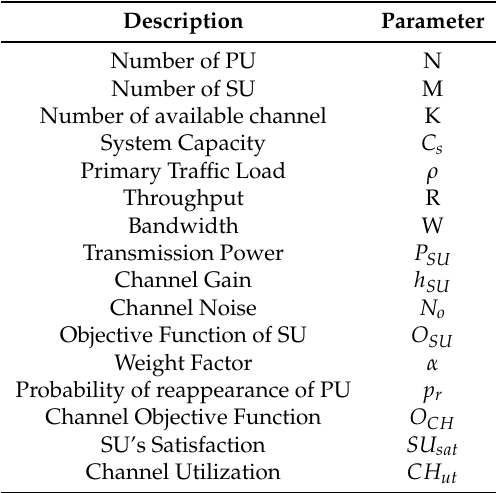
Table 1. List of Notations.